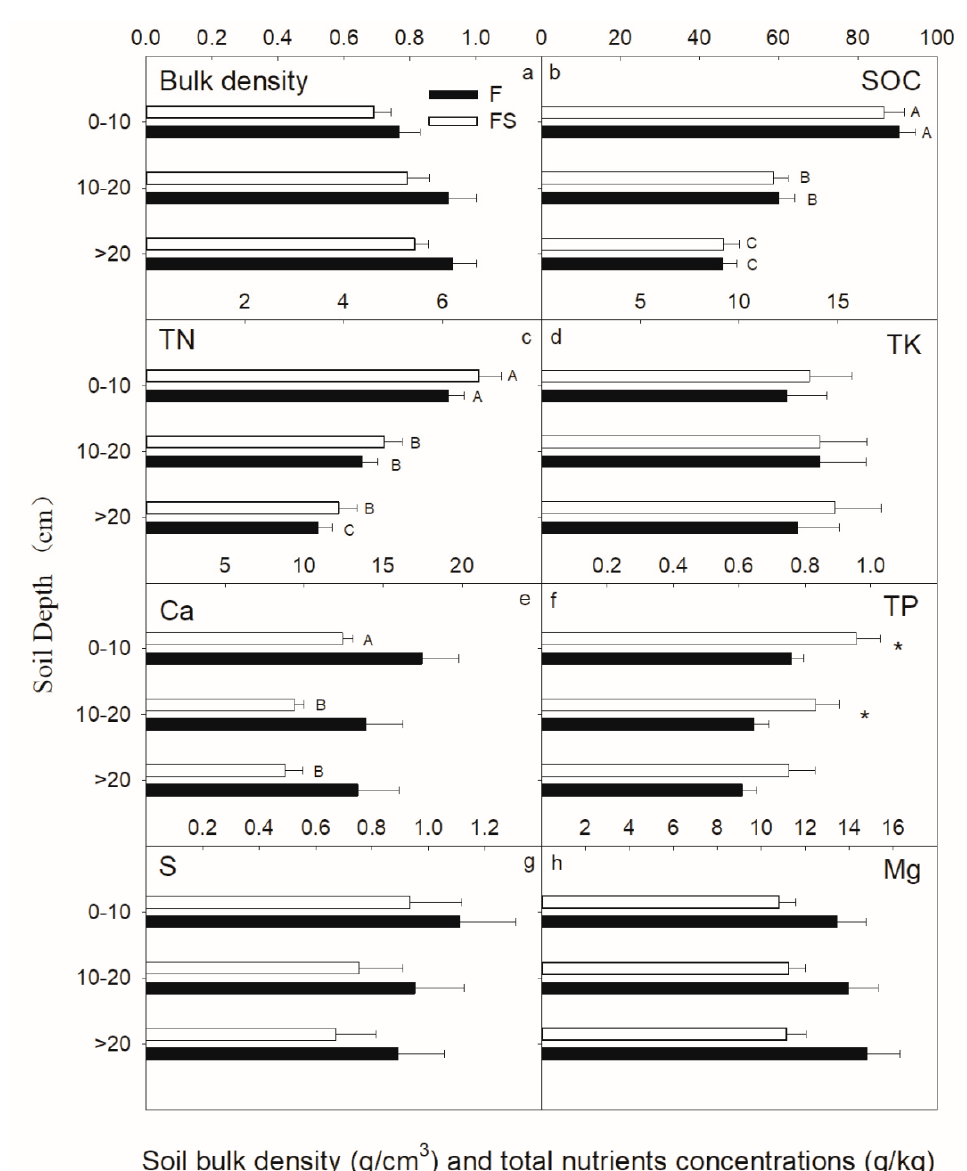
Figure 6. Soil nutrient concentrations of two different vegetation types in southwestern China.